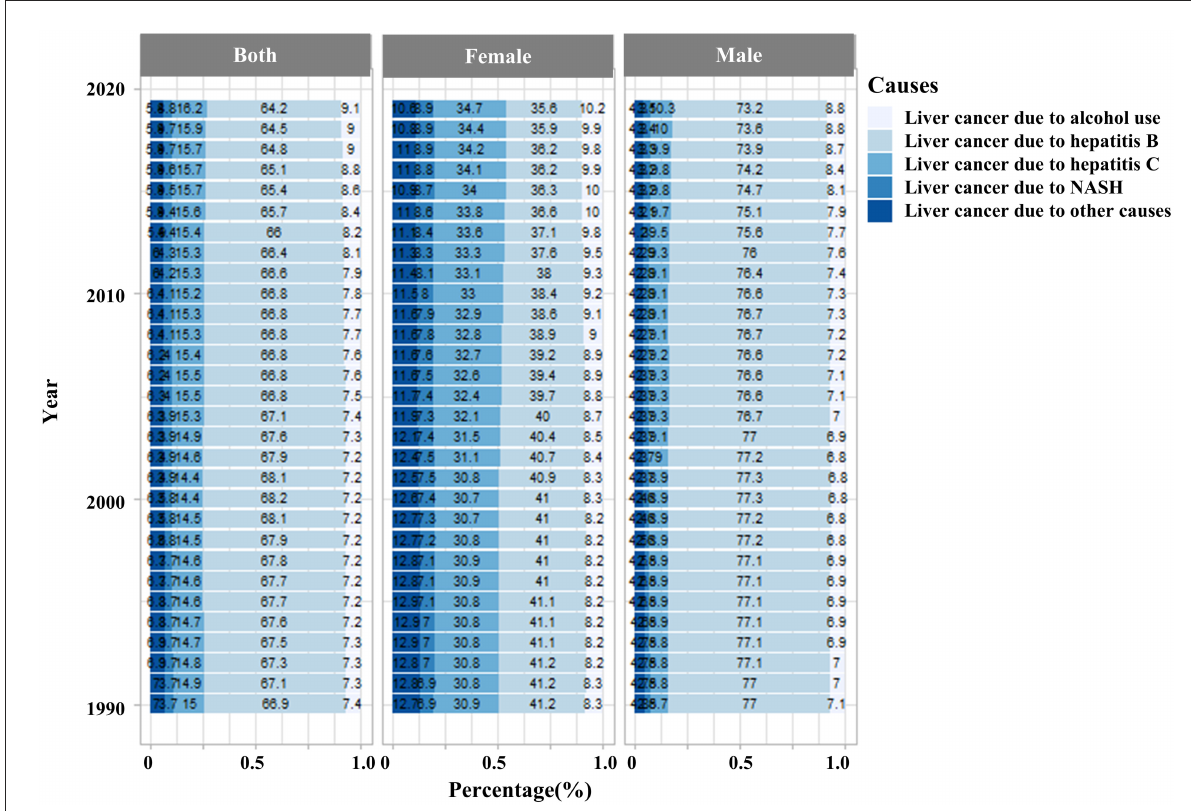
FIGURE2 The disease burden of liver cancer incidence rates in the Chinese population is attributable to five risk factors (alcohol use, hepatitis B, hepatitis C, non-alcoholic steatosis hepatitis, and other causes) between 2010 and 2019. (NASH, non-alcoholic steatosis